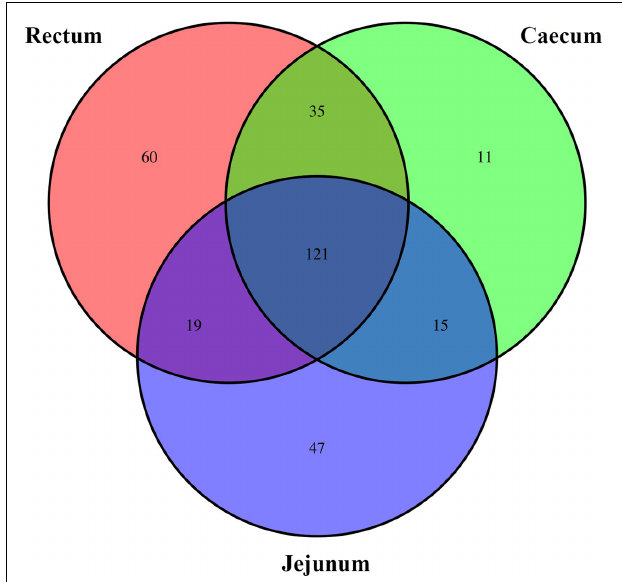
FIGURE 4 | The scalar-Venn representation of share genera among microbiota in different groups.